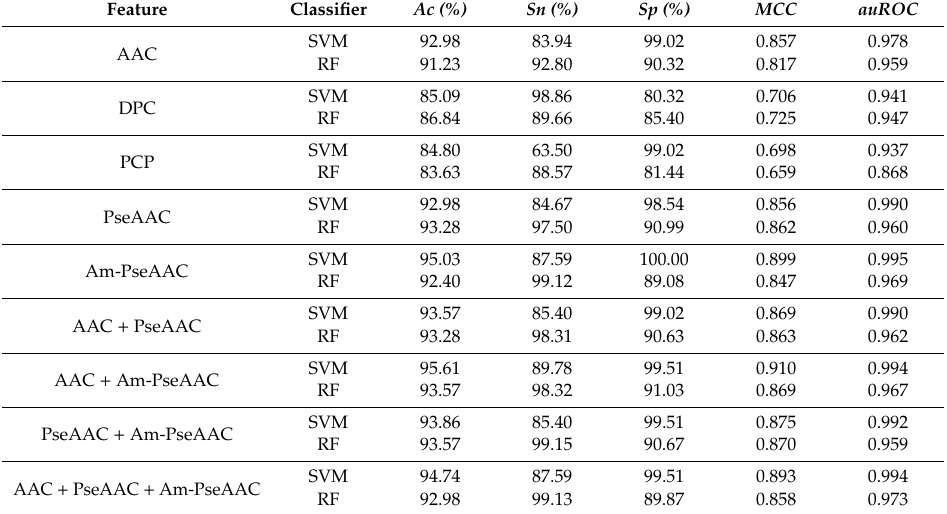
Table 3. Performance comparison of SVM and RF with various types of sequence features over jackknife